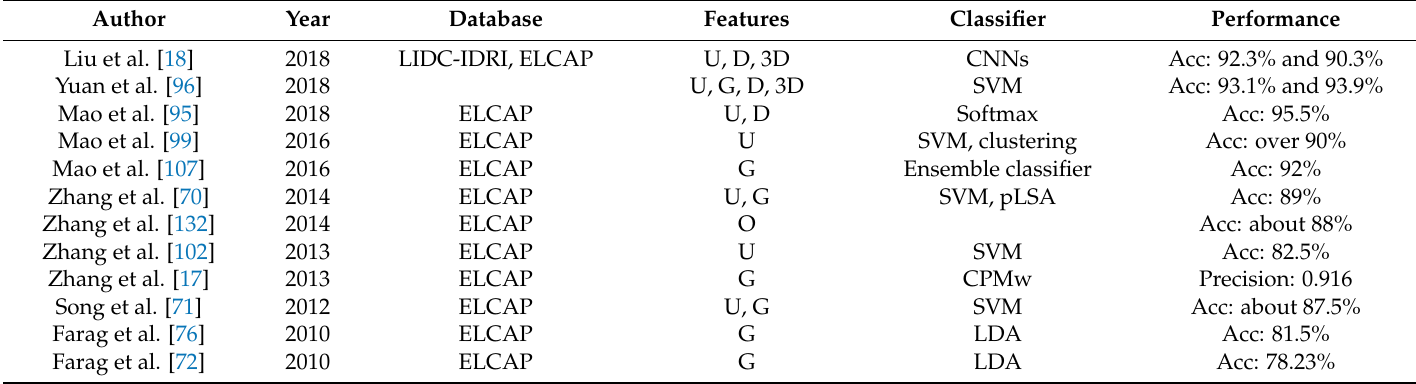
Table 5. Main techniques and comparative analysis of the selected four-type classification. U: User-defined features. G: Generic features. D: deep features. 3D: 3D features. O: other methods. Acc: accuracy. Sen: sensitivity. Spe: